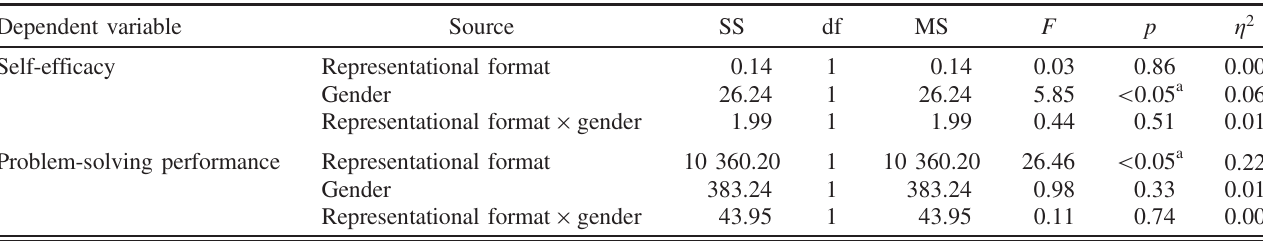
TABLE IV. Results of MANOVA examining the effects of the representational format and gender on self-efficacy and problem- solving